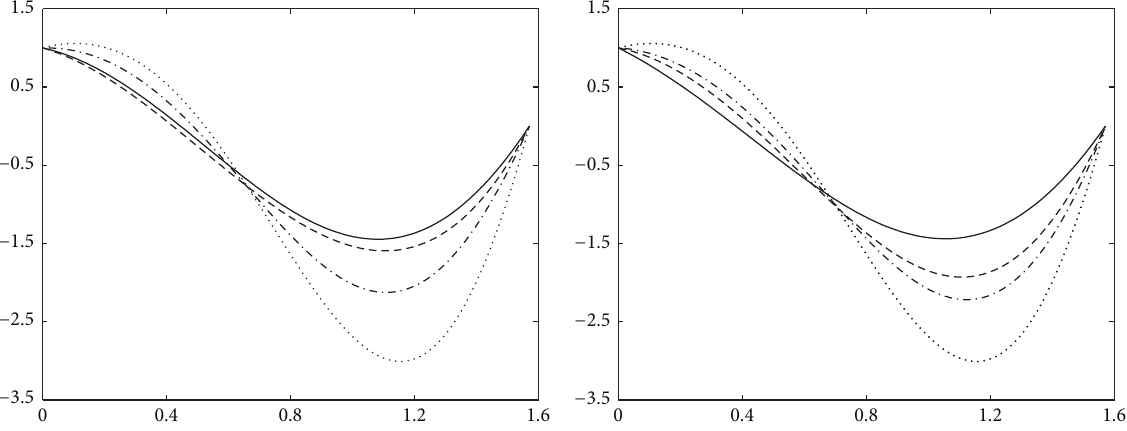
Figure 2: Approximation curves for the function 𝑓 1 .